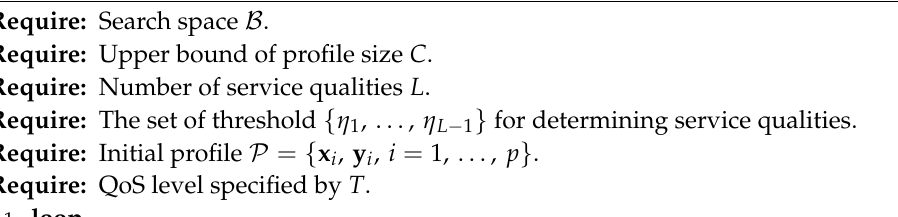
Algorithm 1 The GRNN-based QoS Management